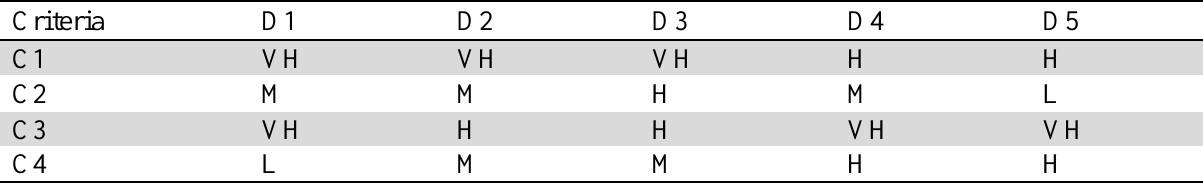
Weightage ranking